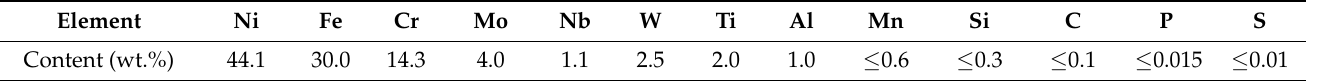
Table 2. Chemical composition of XH45MBTJuBP alloy used in